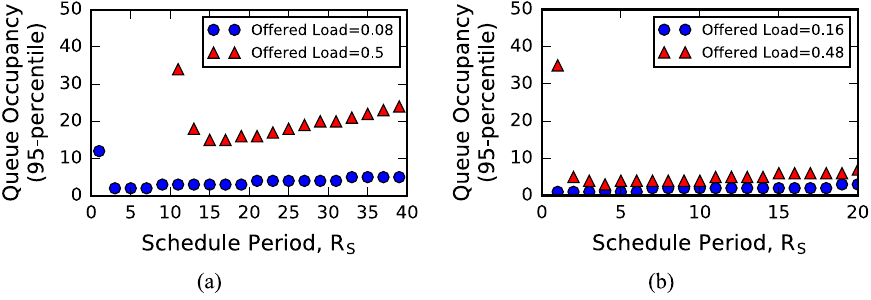
Figure 21. Discrete-event simulation of queue occupancy (95th percentile) vs. schedule period. This is for two sets of parameters with Poisson arrival distribution. The points are empirically measured via the discrete-event simulation. ( a ) C = 10, N = 100, S = 100 ( b ) C = 4, N = 8, S =